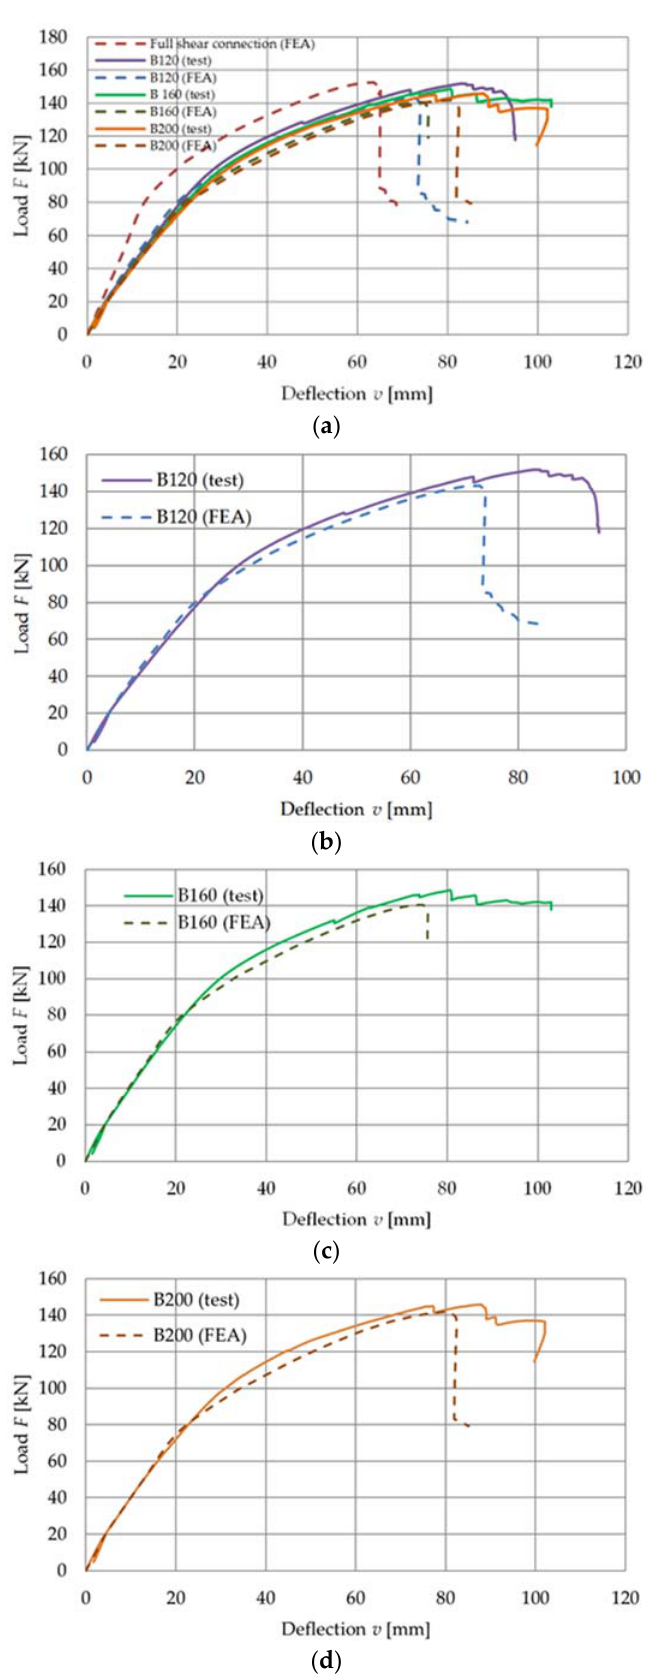
Figure 15. The load versus deflection responses from the test and the numerical analyses: All curves ( a ), B120 ( b ), B160 ( c ), B200 ( d ).